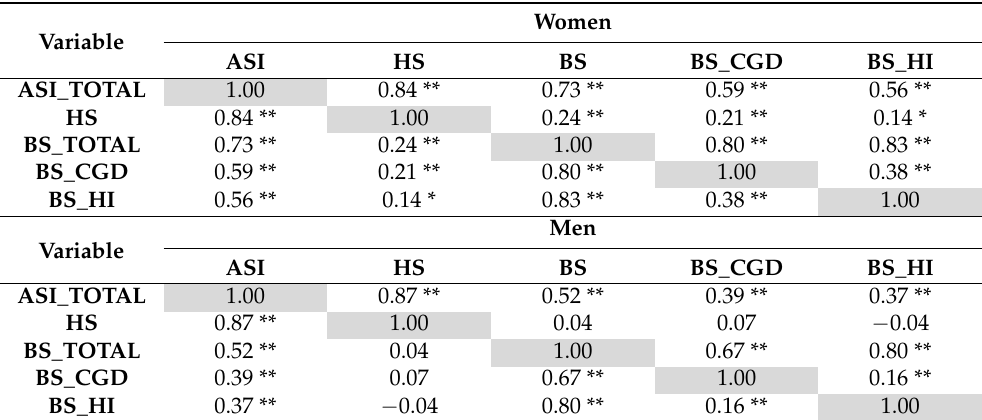
Table 5. Correlations between the validated ASI measures.